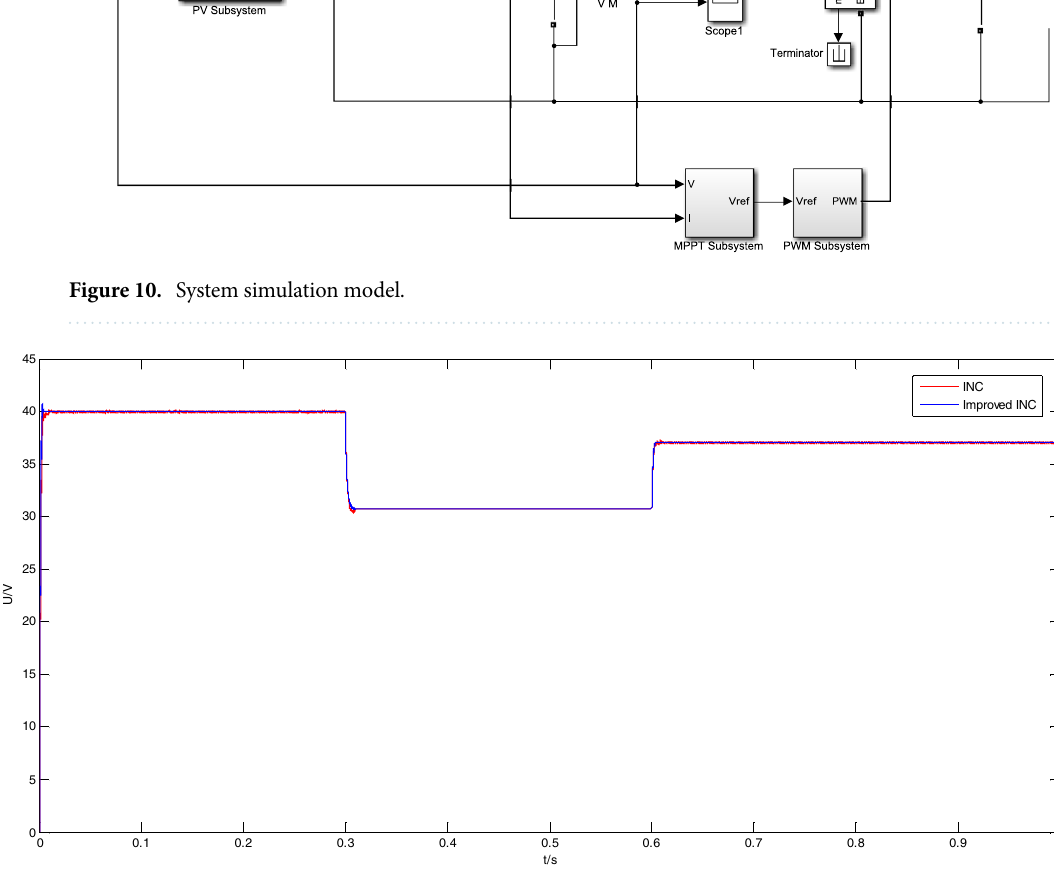
Figure 11. Output voltage simulation results of two conductance increment